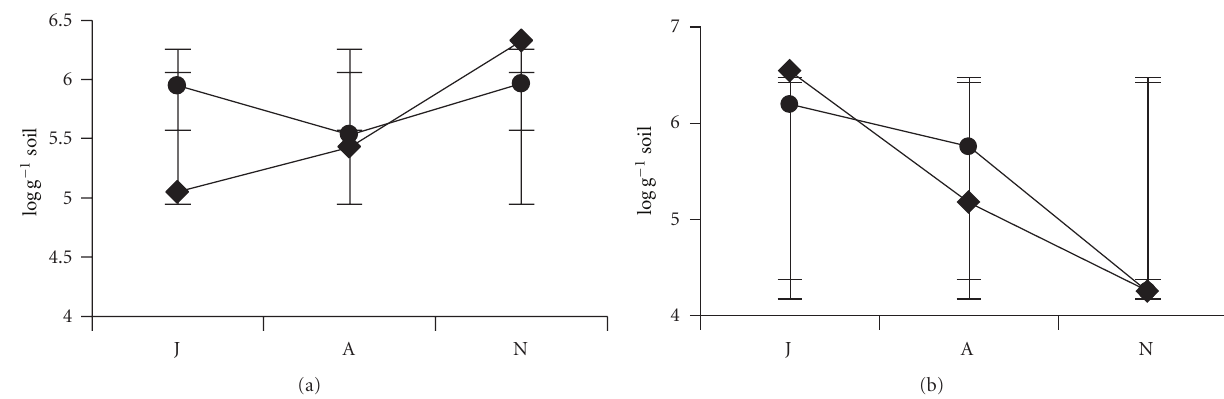
Figure 6: (a) Actinomycete and (b) nonfilamentous hymenomycete numbers on a logarithmic scale displaying di ff erent responses to monoculture and rotation in the di ff erent seasons in 2008. Monoculture = M - (cid:2) -; rotation = R - • -. Vertical bars denote standard deviation.